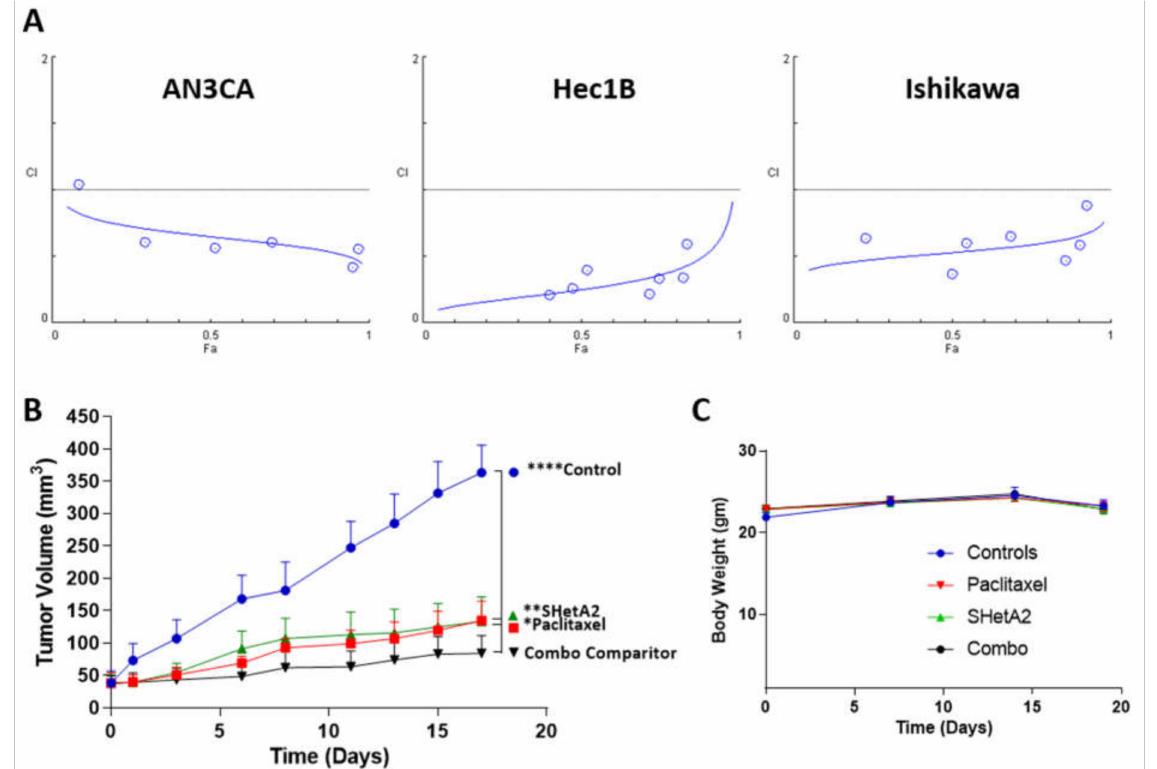
Figure 5. SHetA2 enhances paclitaxel activity without toxicity: ( A ) CIs for endometrial cancer cell lines treated with a series of 2-fold dilutions of SHetA2 and paclitaxel in their 1:1 ratio of their IC 50 concentrations in parallel with single drug treatments. After 72 h, the MTT assay was used to determine theFa’s, and CompuSyn was used to determine the CI’s. CI points below the dotted line indicate synergy. ( B , C ) Mice bearing Ishikawa-endometrial cancer xenografts were treated with oral 60 mg/kg/day SHetA2, 10 mg/kg/week i.p. paclitaxel, combination, or vehicle control. Average tumor volumes ( B ) and body weights ( C ) throughout the study are shown. ANOVA comparison of all treatment groups to the SHetA2 plus paclitaxel treated group (Combo comparator) * p < 0.05, ** p < 0.01 and **** p < 0.0001.